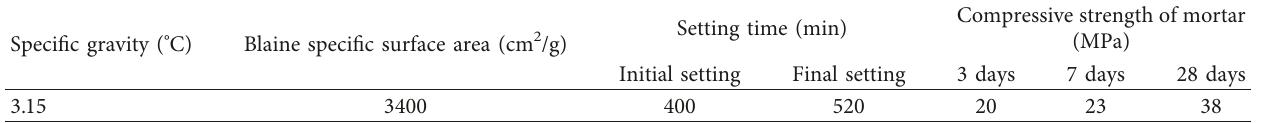
Table 3: Physical properties of the OPC.